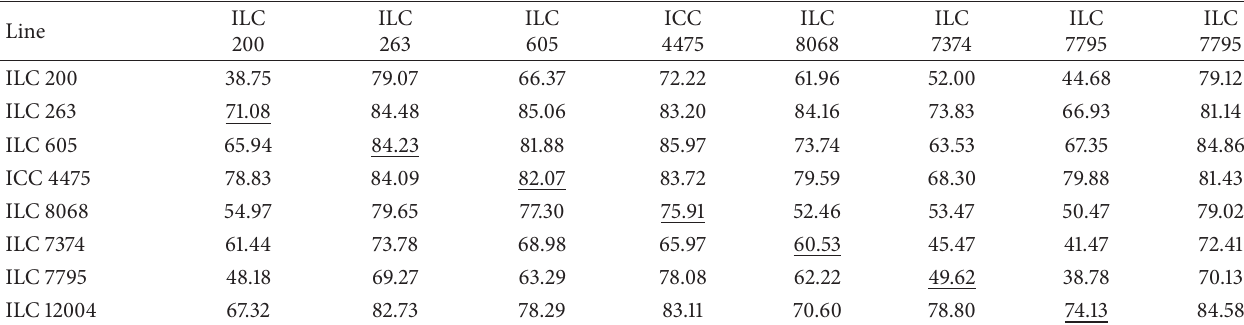
Table 3: Mean value of disease severity of chickpea inoculated by Ascochyta rabiei in a diallel cross at the adult stage for the F1 generation above the underlined data and the F2 generation below the underlined